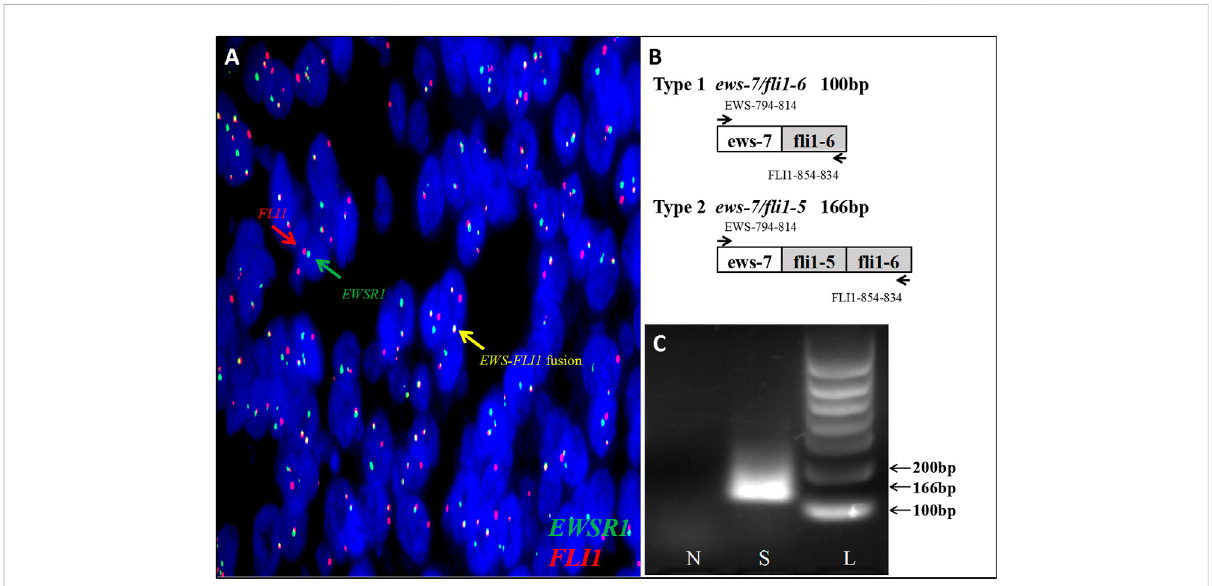
FIGURE 3 (A) FISH testing demonstrated that more than 35% of cells were positive indicating EWS-FLI1 gene rearrangement ( FLI1 gene, red; EWSR1 gene, green; and EWS-FLI1 fusion gene, yellow). (B) Fusion of EWS -exon 7 to FLI1 -exon 6 ( ews-7/ fl i1-6 ) creates a PCR product of 100 bp, while fusion